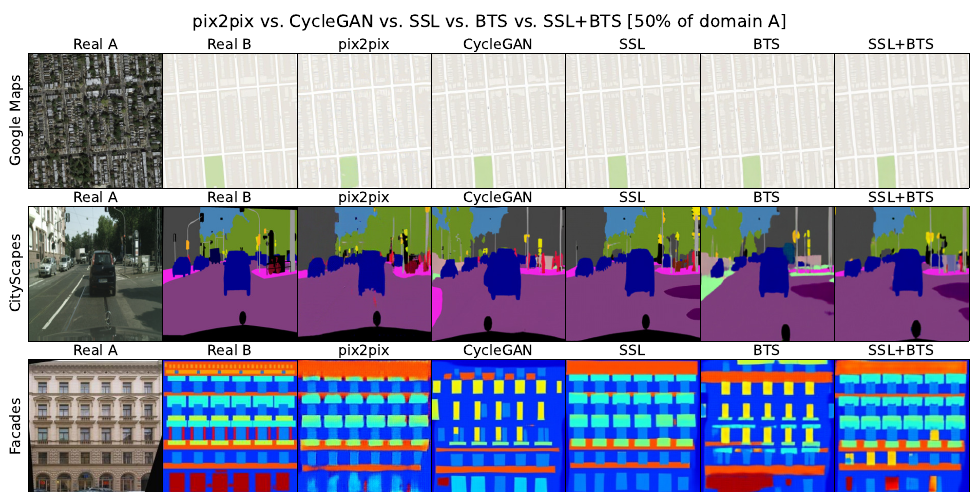
Figure 5. Visual examples of the proposed vs. baseline algorithm comparisons for 50% of the scarce domain data used: Real A (scarce domain) and Real B (target domain) correspond to image pair examples. Examples are given for Google Maps , CityScapes and Facade datasets. SSL denotes that only SSL on the control part of pared images is included in the training of CycleGAN, BTS denotes that only bootstrapping of the statistic of the A discriminator pool is included in the training, while SSL+BTS denotes that both SSL and BTS are